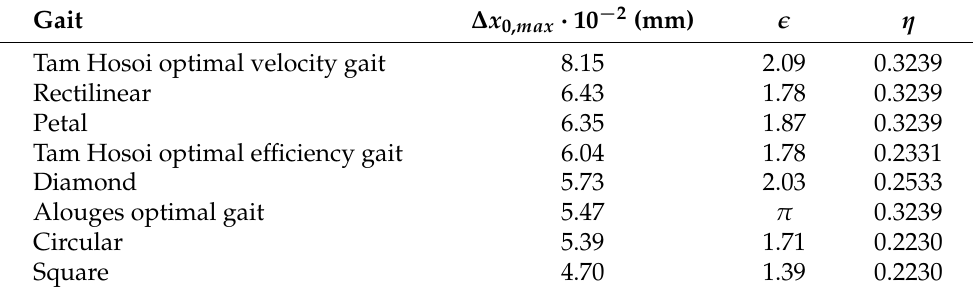
Table 1. Optimal values of gait amplitude ( (cid:101) ) and relation between lengths of the links ( η ) for maximum displacement. The data are sorted in order of decreasing